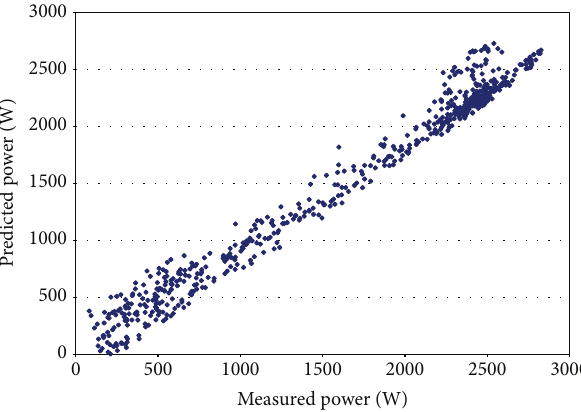
Figure 6: Output power prediction for Model #1, which selects sunny and cloudy data randomly.